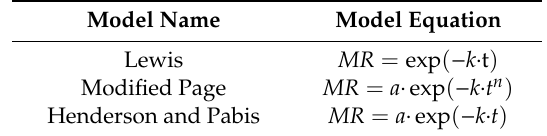
Table 7. Mathematical models applied to drying curves of Strobilanthes crispus